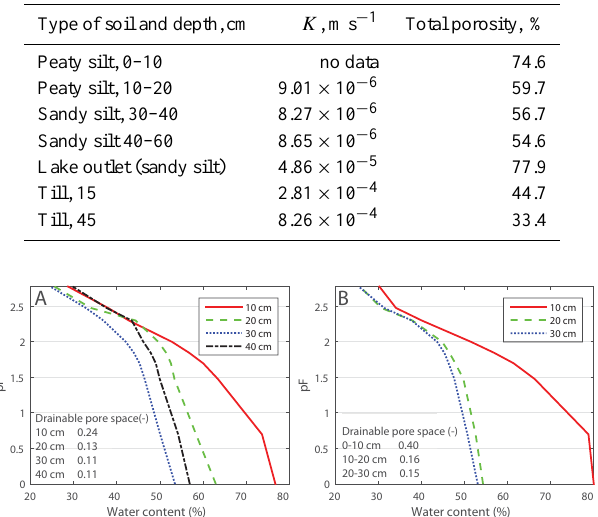
Figure 6. pF curves and drainable pore space (saturated water con- tent – water content at field capacity) based on data from 40 undis- turbed soil samples (a–b) . Data from the 10 and 20cm levels in (a) represent a peaty silt soil, and data from the 30 and 40cm levels represent an aeolian silt. In (b) , all data represent an aeolian